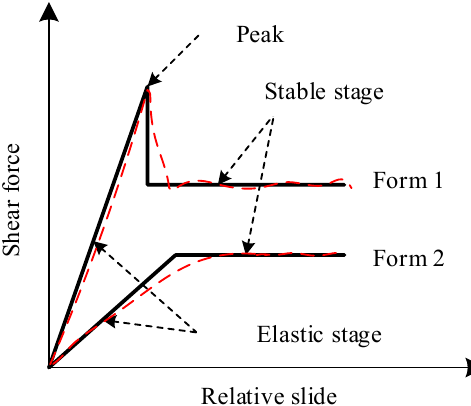
Figure 12. Simplified forms of interlayer shear force-relative slide curves.